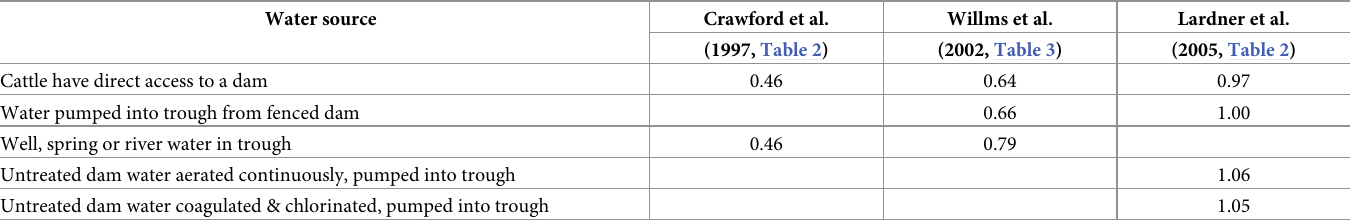
Table 1. Weight gain by steers drinking poor versus good quality water